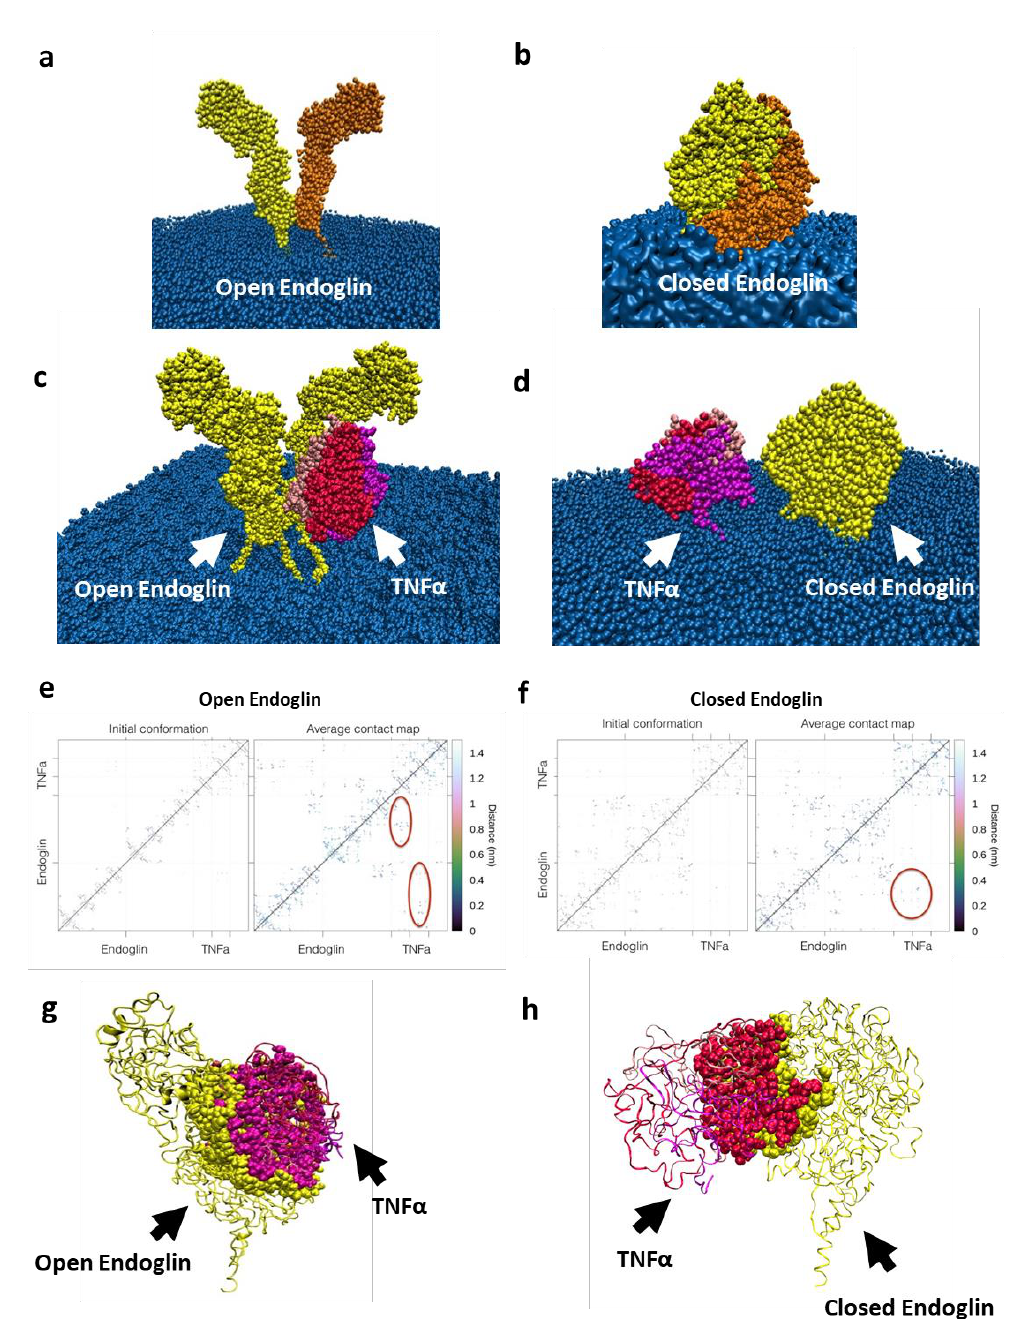
Figure 2. TNF α and endoglin interaction. ( a ) Endoglin alone embedded in the membrane. The two arms of the molecule are colored in yellow and orange, respectively, to show the two homodimeric parts of the molecule. ( b ) Endoglin during the simulation in its closed form with the two arms wrapping around each other. ( c ) Initial configuration of TNF α ligand (trimeric form in red and pink) and endoglin (homodimeric form in yellow) in “open” conformation. Endoglin is embedded in the phospholipidic membrane (blue). ( d ) Initial conformation of TNF α ligand and endoglin in “closed” conformation. ( e ) Contact maps of the TNF α and open endoglin in the initial conformation (right) and of the average computed over the whole simulation (left). The circles in red highlight the region of contact of the aggregate. ( f ) Contact maps of the TNF α and closed endoglin in the initial conformation (right) and of the average computed over the whole simulation (left). The circle in red highlights the region of contact of the aggregate. ( g ) Representative surface contact between TNF α and open endoglin; 137 residues of TNFα are in contact with endoglin. ( h ) Representative surface contact between TNFα and closed endoglin; 54 residues of TNFα are in contact with endoglin , while 21 residues are in contact in both the “ open ” and “ closed ” simulations.